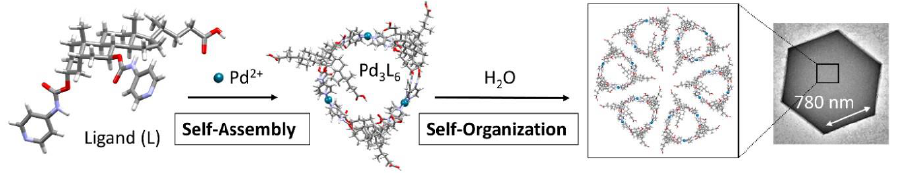
Figure 1. Self-assembly of bile acid-based coordination complexes Pd 3 L 6 and their self-organization into microparticles [3].